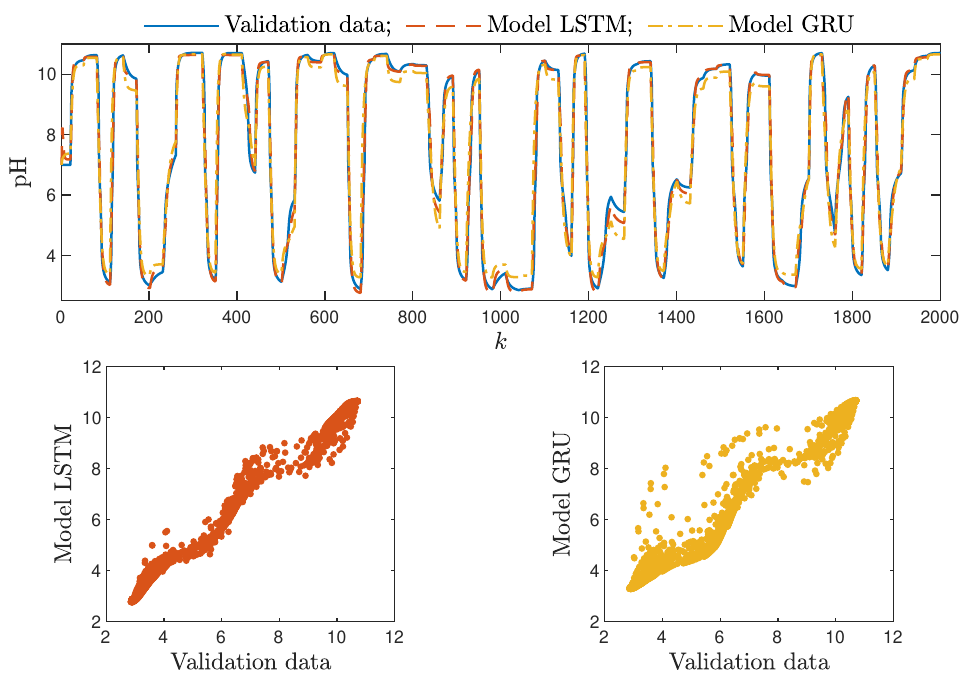
Figure 9. The neutralisation reactor: the validation dataset vs. the output of the LSTM and GRU models for n N = 1, n A = n B = 1.